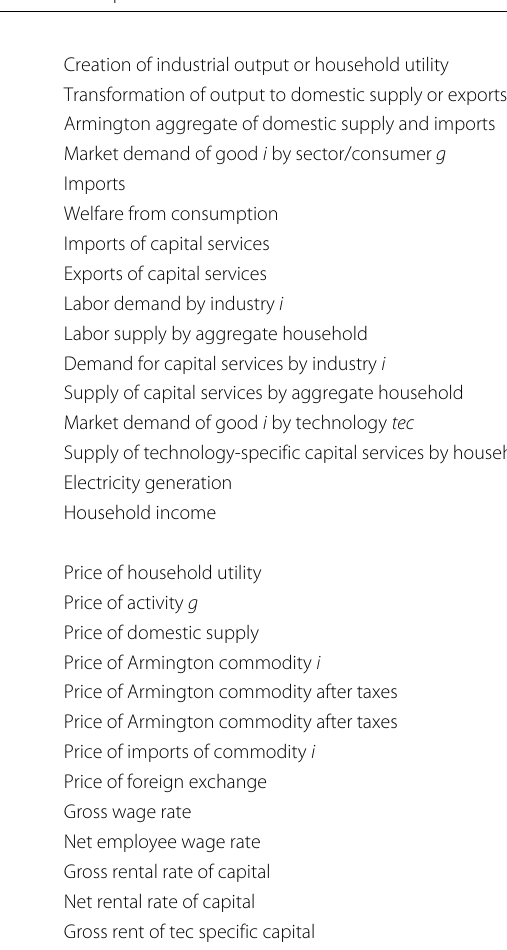
Table 14 Variables in the CEPE model